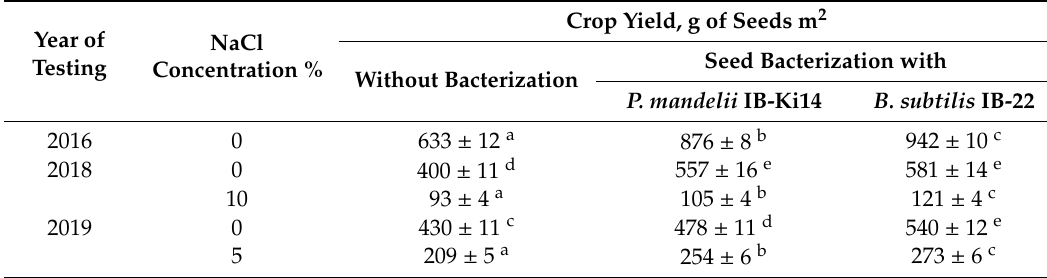
Table 1. E ff ect of seed bacterization on crop yield under stress-free conditions and salinity.